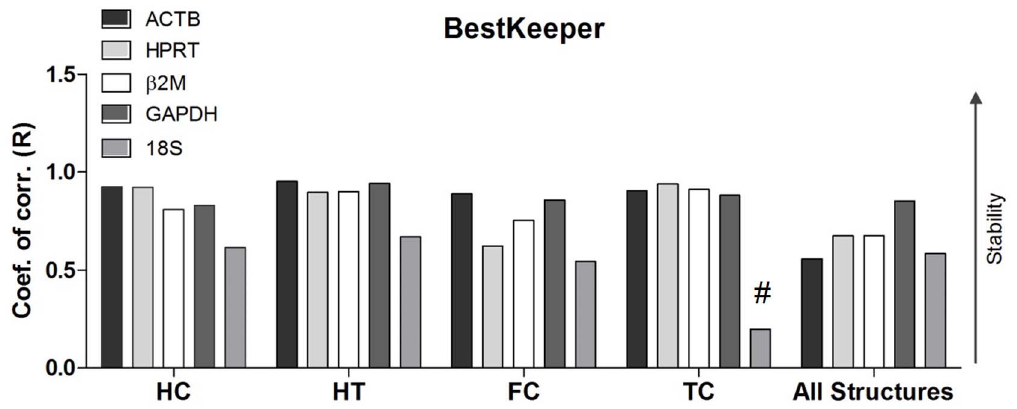
Figure 4. BestKeeper stability analysis. Evaluation of gene expression stability by BestKeeper for individual brain regions. The Pearson correlation coefficient (R) of all HKG candidates. All HKG except 18S in the temporal cortex, presented significant correlation (P , 0.05), as determined by Pearson correlation analysis. # : P . 0.05 HC, hippocampus; HT, hypothalamus; FC, frontal cortex; TC, temporal cortex.